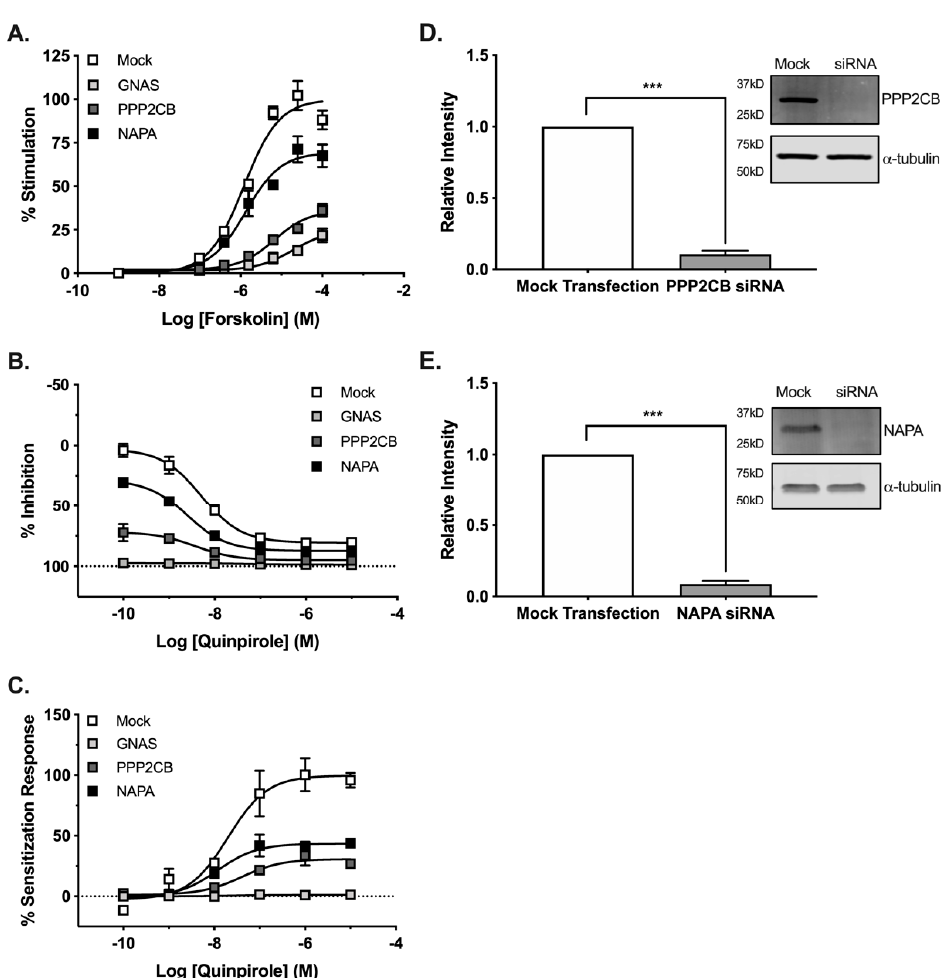
Figure 5. Target gene knockdown reduces maximal adenylyl cyclase activity in CAD VN-AC5/D